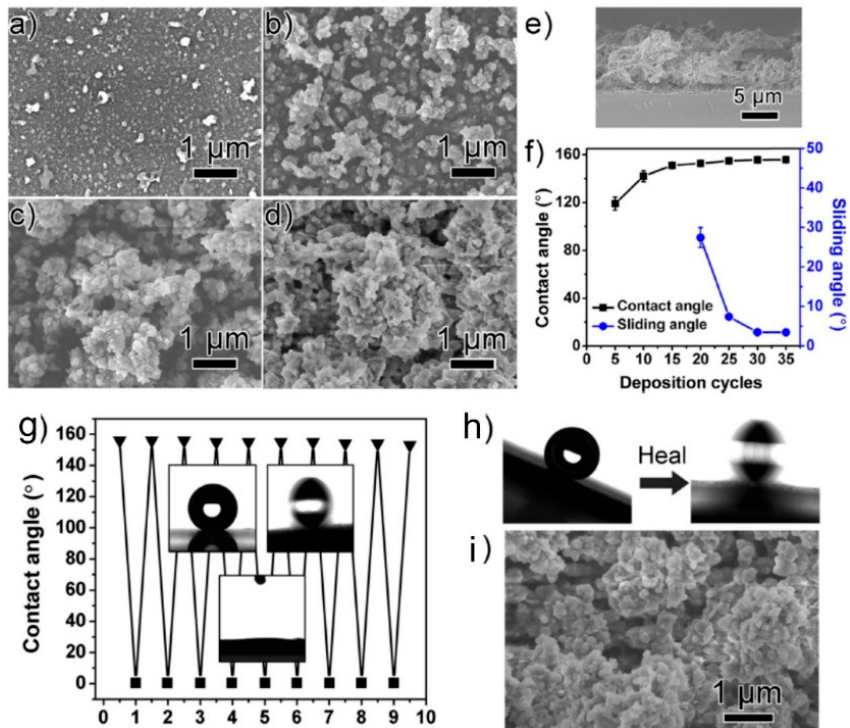
Figure 7. Top ‐ view SEM images of the (PSS − ODA 1.5 /PAH − SDS)*n fi lms, with n being 5 ( a ), 15 ( b ), 25 ( c ), and 30 ( d ). ( e ) Cross ‐ sectional SEM image of the (PSS − ODA 1.5 /PAH − SDS)*30 fi lm. ( f ) Changes in water contact angles and sliding angles of the (PSS − ODA 1.5 /PAH − SDS)*n fi lms with di ff erent dep ‐ osition cycles ( g ) changes in the water contact angle of the superhydrophobic (PSS − ODA 1.5 /PAH − SDS)*30 fi lm upon repeated O 2 plasma etching ( ■ ) and self ‐ healing ( ▼ ). Insets: shapes of the water droplets (4 μ L) of the as ‐ prepared (top left), O 2 ‐ plasma ‐ etched (bottom), and healed (top right) superhydrophobic films. ( h ) Shapes of the water droplets of the sand ‐ impinged (PSS − ODA 1.5 /PAH − SDS)*30 fi lms before (left) and after (right) the self ‐ healing process. ( i ) Top ‐ view SEM image of the sand ‐ impinged (PSS − ODA 1.5 /PAH − SDS)*30 fi lm. Reprinted with permission from [81] 2016 ACS Publications